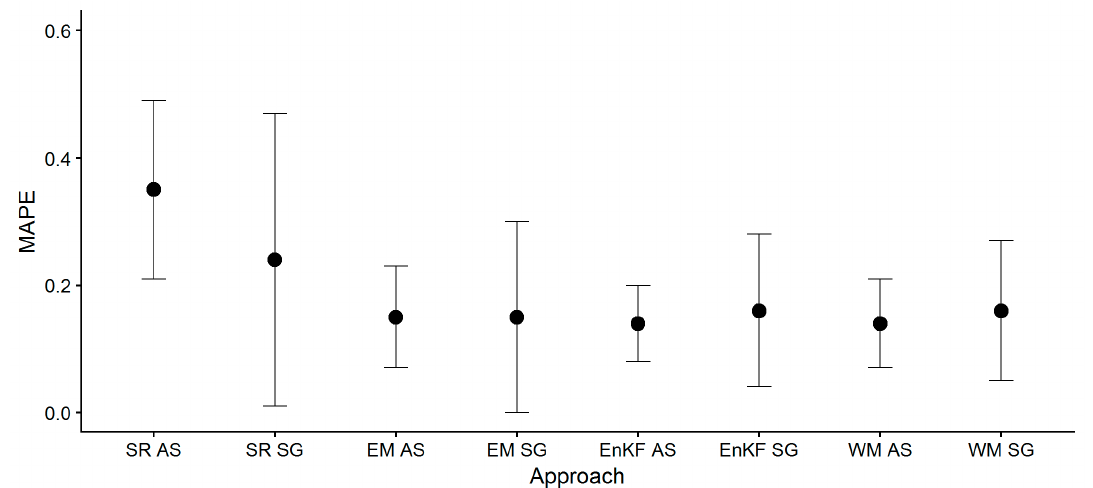
Figure 4. Mean and standard deviation of total aboveground biomass mean absolute percentage error (MAPE in decimal-%) for tested approaches. SR: standard run, EnKF: ensemble Kalman filter, EM: ensemble mean, WM: weighted mean, AS: analyzed soil texture used as model input, SG: SoilGrids-derived soil texture as model